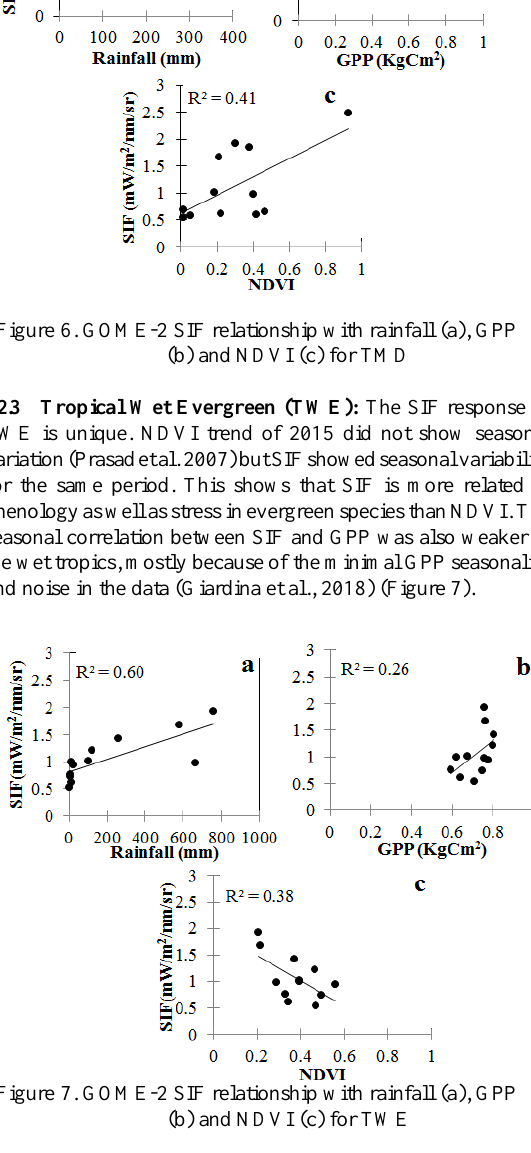
Figure 4. Time- series trends analysis for monthly variable [SIF (GOME-2), GPPMODIS, NDVIMODIS, and Rainfall (RF)] from 2014 to 2017 (n=48).